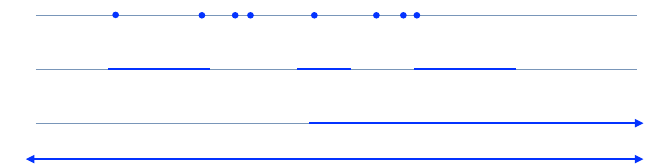
Figure 1 . Examples of definable sets of R